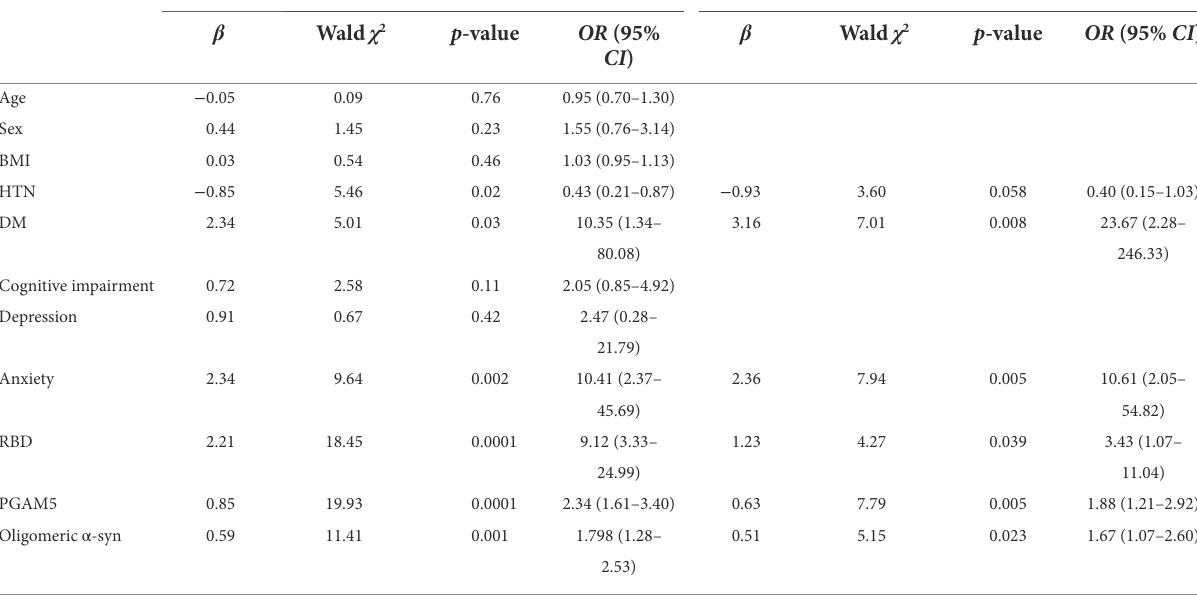
TABLE 3 Univariable and multivariate analysis on plasma PGAM5 and oligomeric α -sync levels and other clinical characteristics in logistic regression. Variables Univariable analysis Multivariable